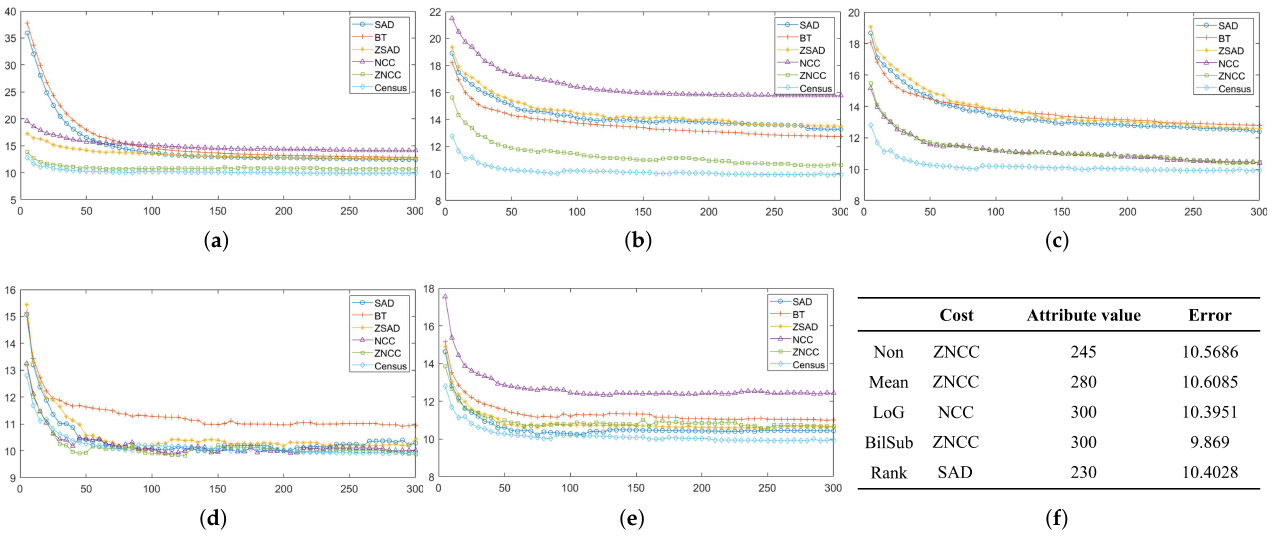
Figure 7. Errors of combinations of the cost and image filter using the window-based stereo method, according to the variation of the pattern intensity parameter. ( a ) Non-filter. ( b ) Mean. ( c ) LoG. ( d ) BilSub. ( e ) Rank. ( f ) Best of Window.